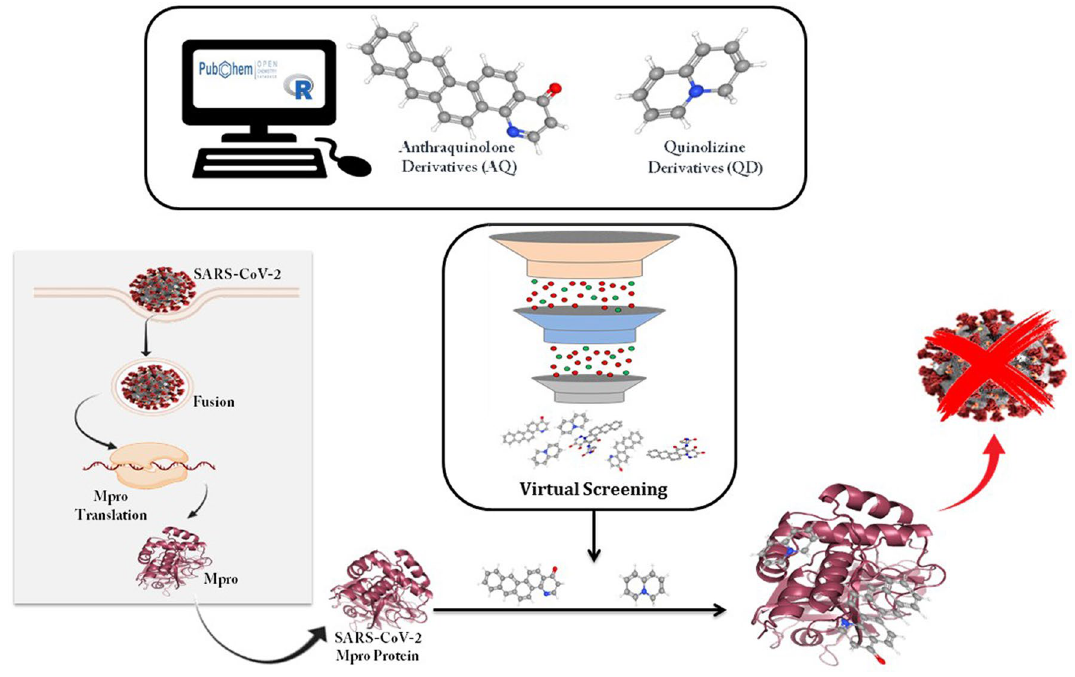
Figure 1. Diagrammatic representation of running machine learning algorithms and Virtual Screening performed for Anthraquinolone (AQ) and Quinolizine (QZ) derivatives against SARS-CoV-2 M pro